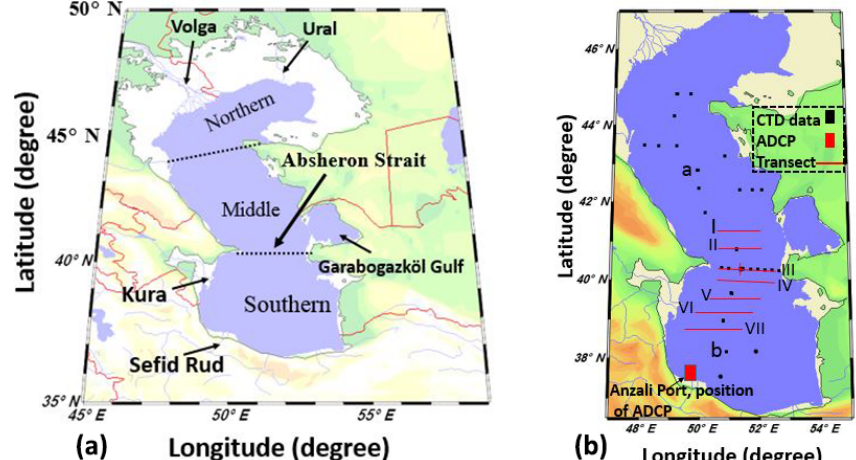
Figure 1. (a) Schematic diagram of the Caspian Sea showing the locations of the most important rivers namely the Volga, Ural, Kura and Sefid Rud; the Garabogazköl Gulf and the Absheron Strait are also shown on the map. (b) The locations of the CTD and ADCP measurements and the geographic position of the transects are shown. The CTD casts are for 42 stations for the month of September in both 1995 and 1996. The CTD stations (labeled a and b) are emphasized because the physical properties of the waters for these stations are presented in Fig. 2a and b. ADCP data are recorded from November 2004 to the end of January 2005 to validate the numerical simulations.